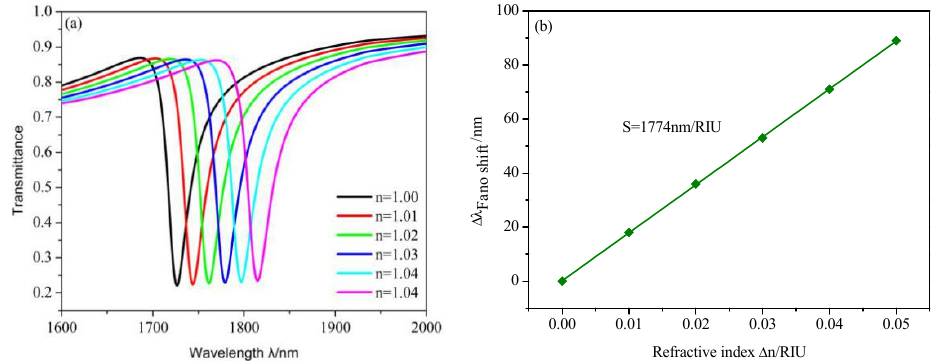
Figure 6. ( a ) Transmission spectra of the refractive indices ranging from 1.00 to 1.05 RIU. ( b ) Linear fitting of the sensitivity. Table 1. Comparisons of results with previous